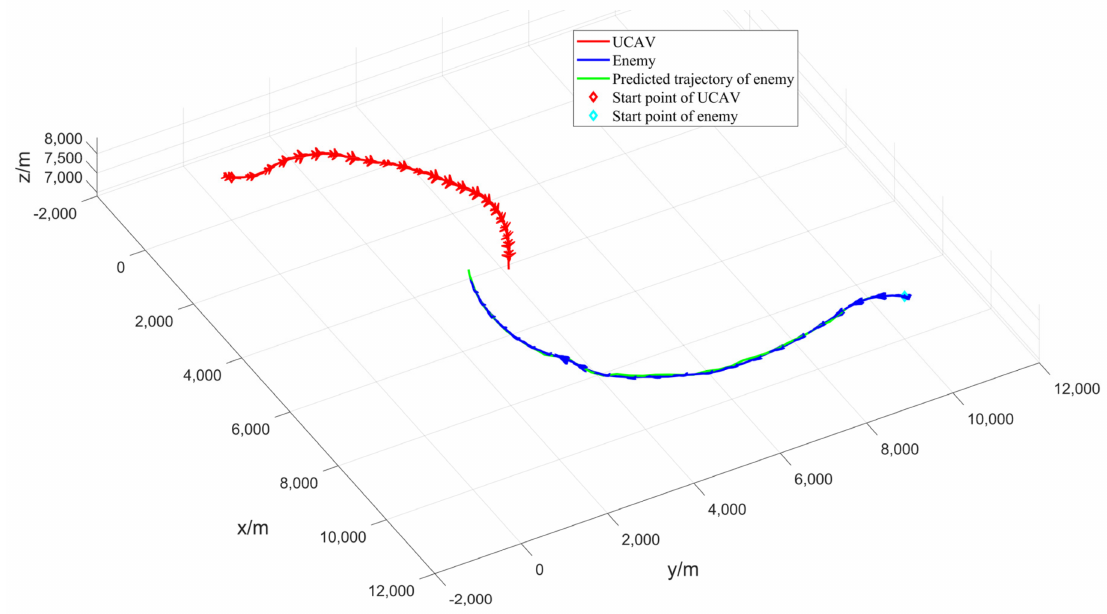
Figure 14. Three-dimensional air combat trajectory and predicted trajectory